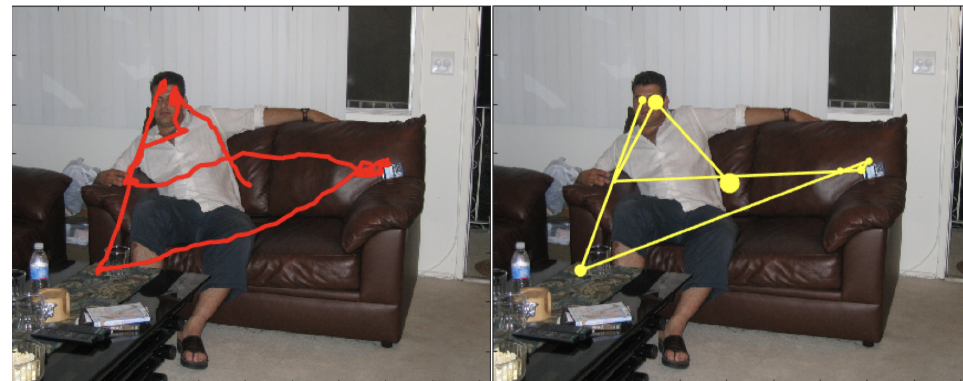
Figure 2. The dynamics of one observer’s gaze while visually foraging on the image landscape as recorded through an eye-tracking device. Left : the “raw data” represented as a time-sequence of spatial coordinates (red dots) displayed as the red trace overlapped on the viewed image. Right : the observer’s scan path, namely, the continuous raw data trace parsed into a discrete sequence of fixations (yellow disks) and saccades (segments between subsequent fixations); disk radius is proportional to fixation time. Image and eye-tracking data are publicly available from the FIFA dataset [15]. Table 1. Relationship between Visual Attention and Foraging. Visual Attentive Processing of a